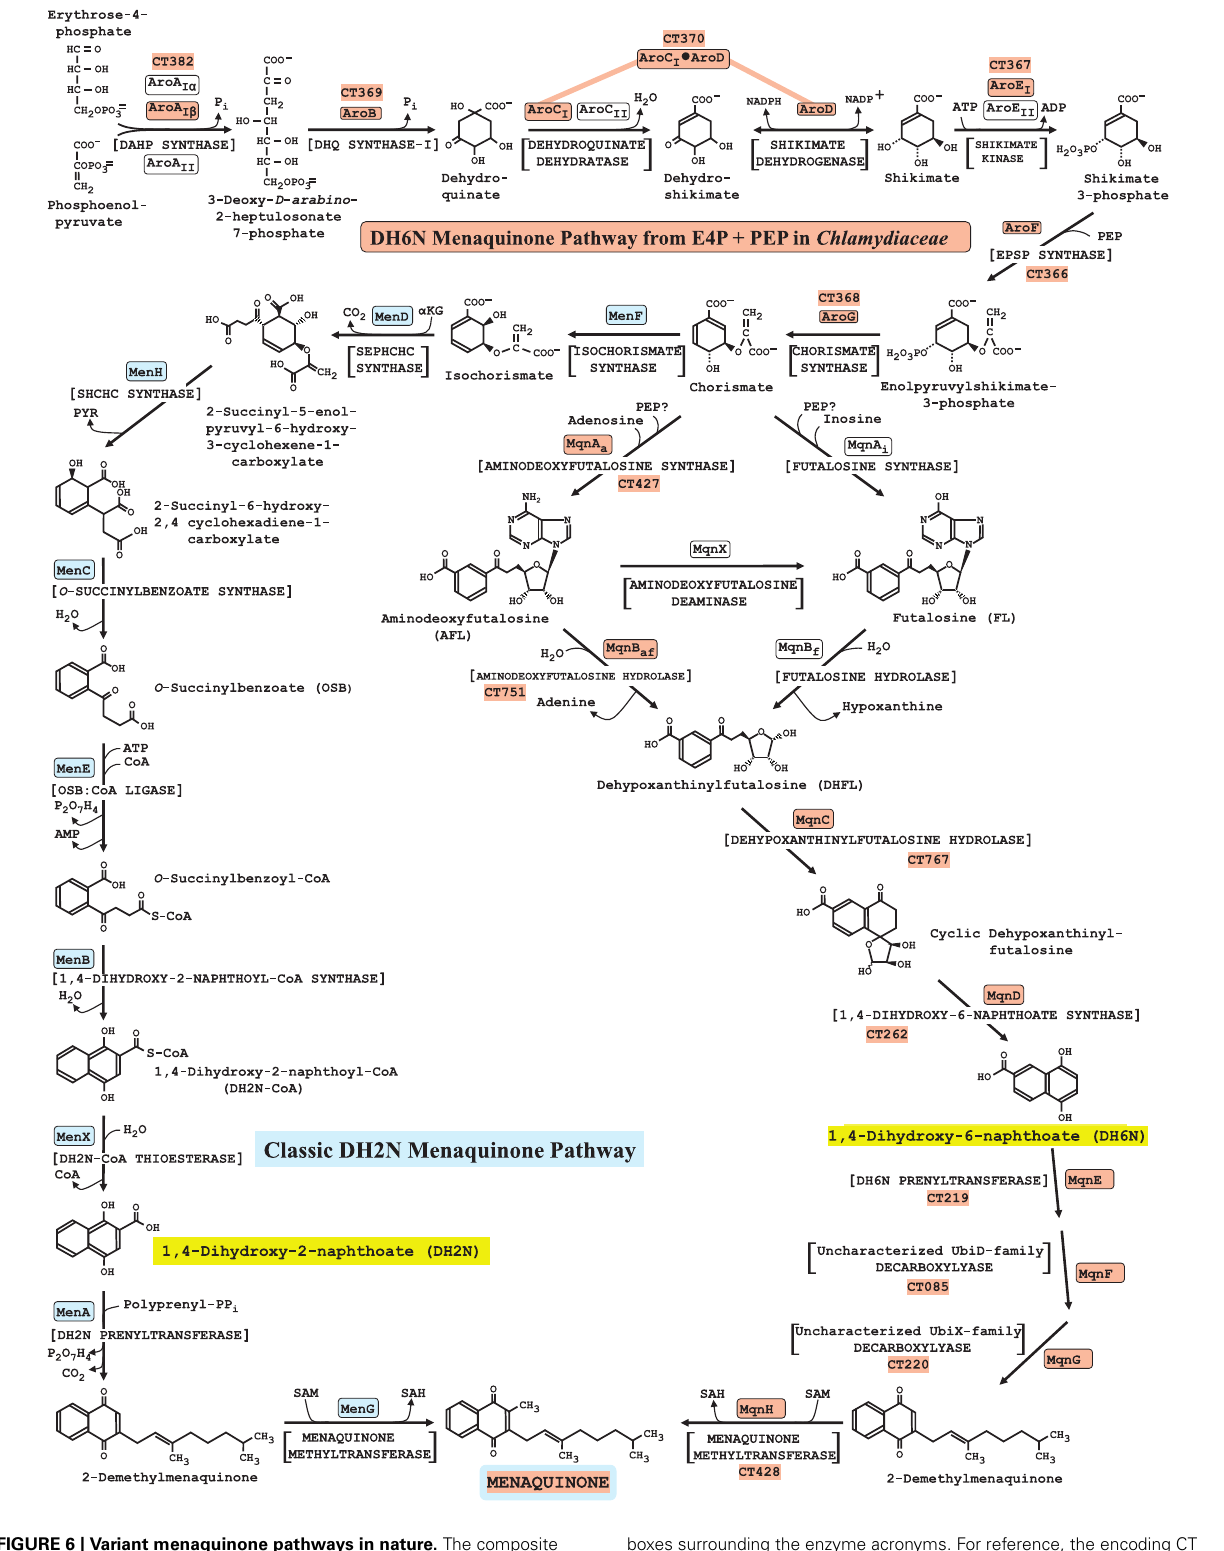
boxes surrounding the enzyme acronyms. For reference, the encoding CT gene numbers for C. trachomatis D/UW-3/CX are also shown. Multiple acronyms are indicated for the three enzyme steps in the chorismate